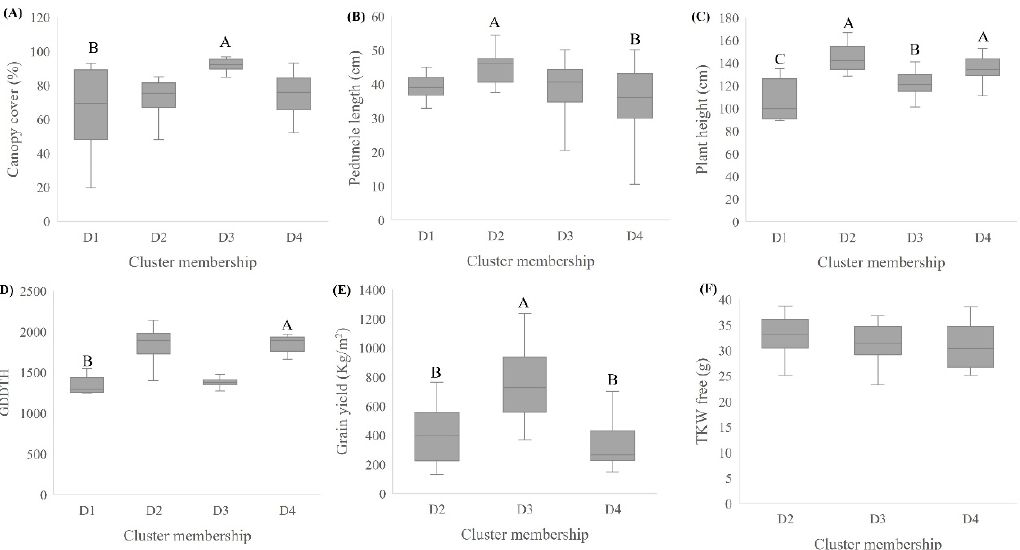
Figure 3. Box plot of agronomic traits by clusters: ( A ) canopy cover (%), ( B ) peduncle length, ( C ) plant height, ( D ) GDD to heading, ( E ) grain yield, and ( F ) TKW. Different letters, in the bars, indicate significant differences at p ≤ 0.05 following a mean comparison both Welch ( A , B , D ) tests were applied and Tukey–Kramer ( C , E , F ). Figure 5. Linear regression models for the effect of ecogeographical parameters on genetic related- ness. ( A ) The estimated effect and the residuals for each of the six parameters included in the linear model,). ‘***’ represents the significance level p < 0.0001 ‘**’ represents the same p < 0.001. ( B – E ) Scatter plots between the genetic relatedness calculated with MDS and temperature range and pre- cipitation parameters. Each cluster is denoted with a different color.